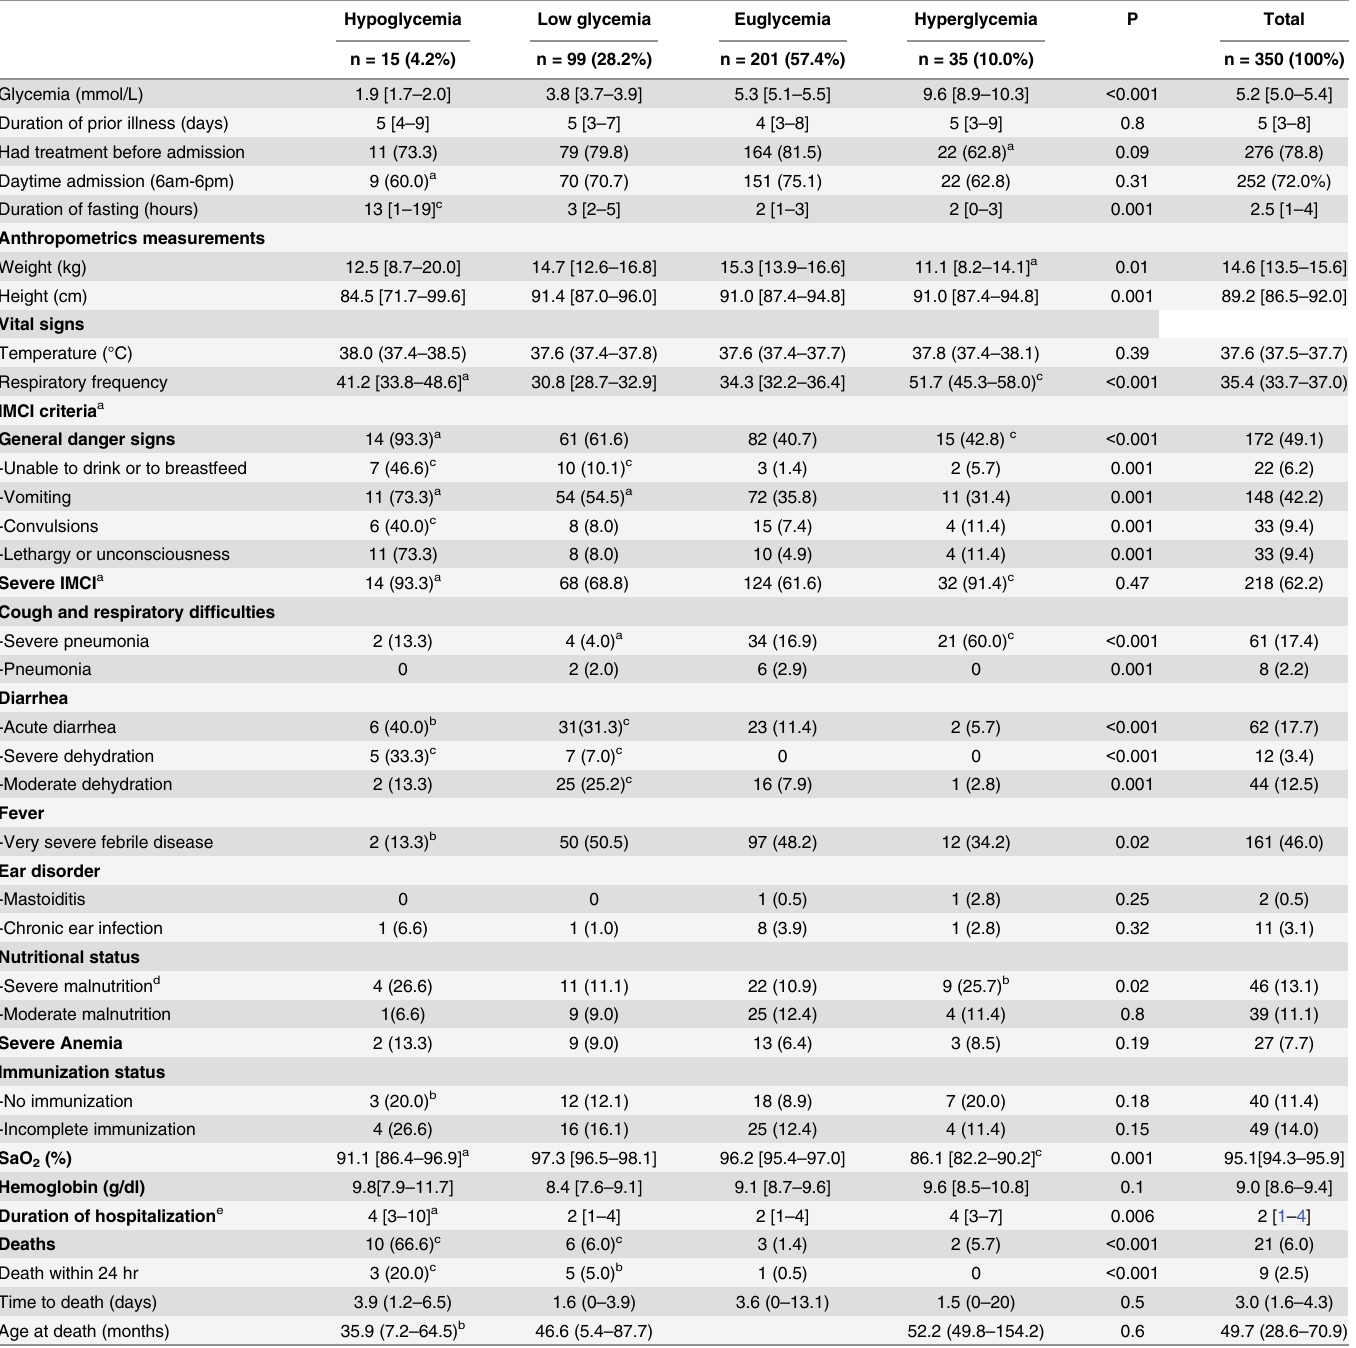
Table 3. Medical characteristics of children according to IMCI algorithm a